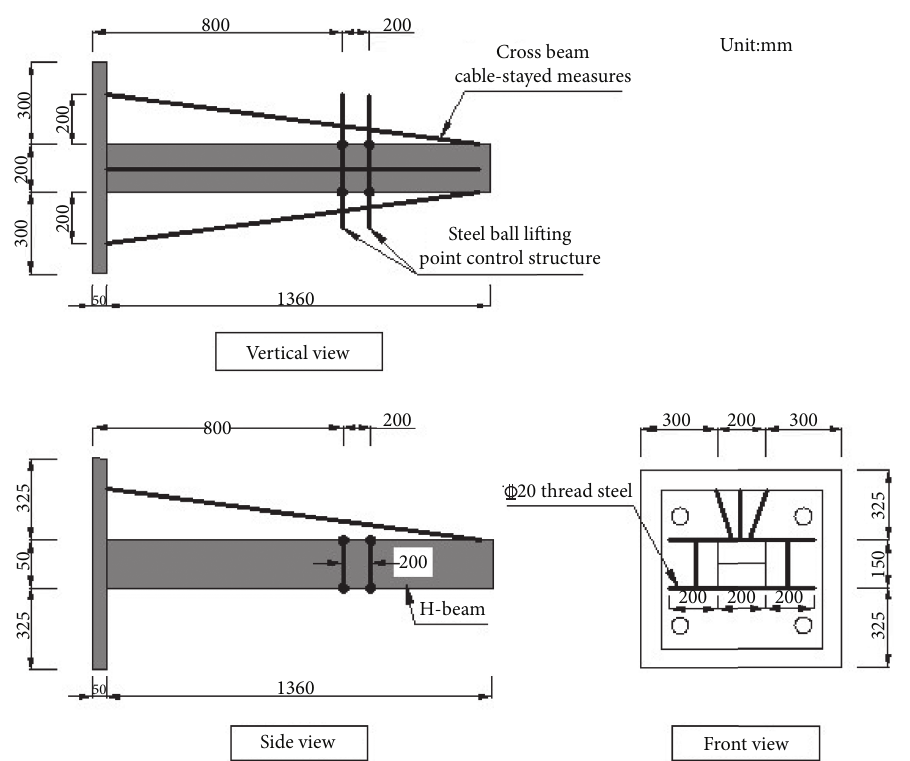
Figure 8: Design of the support beam.